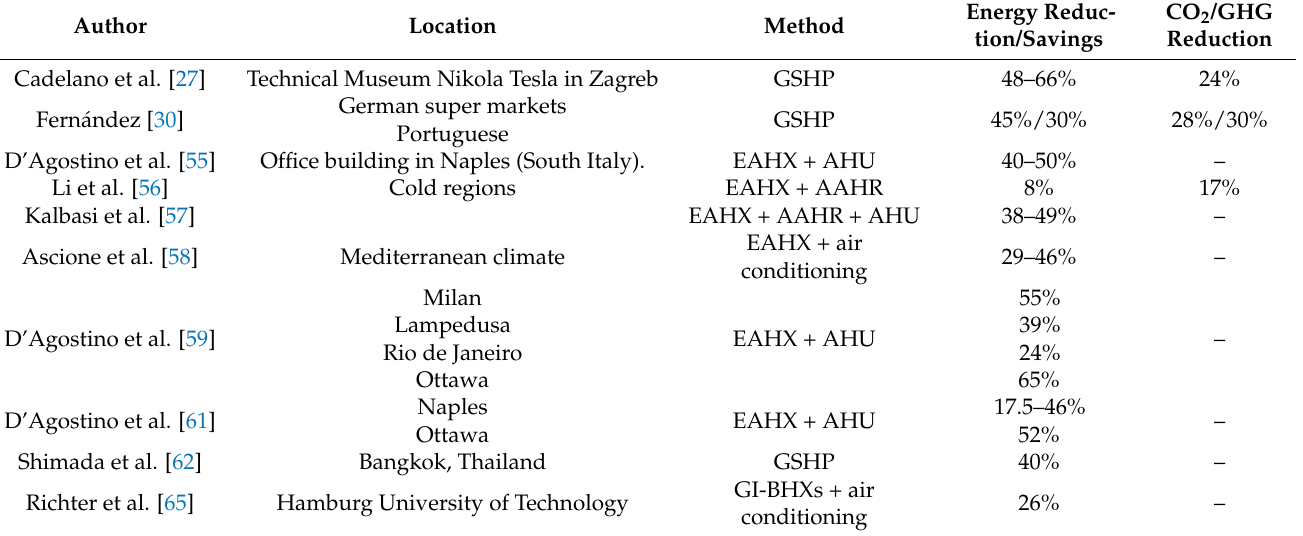
Table 1. Energy savings through geothermal